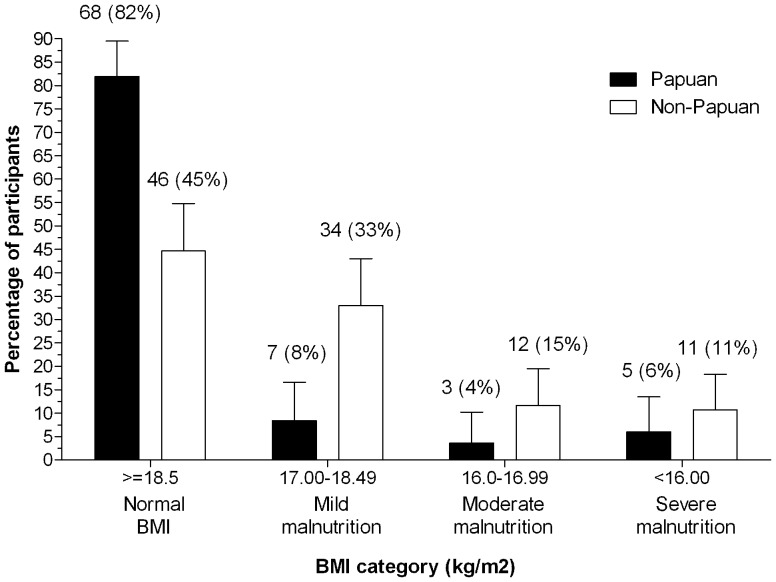
Body mass index at TB diagnosis.